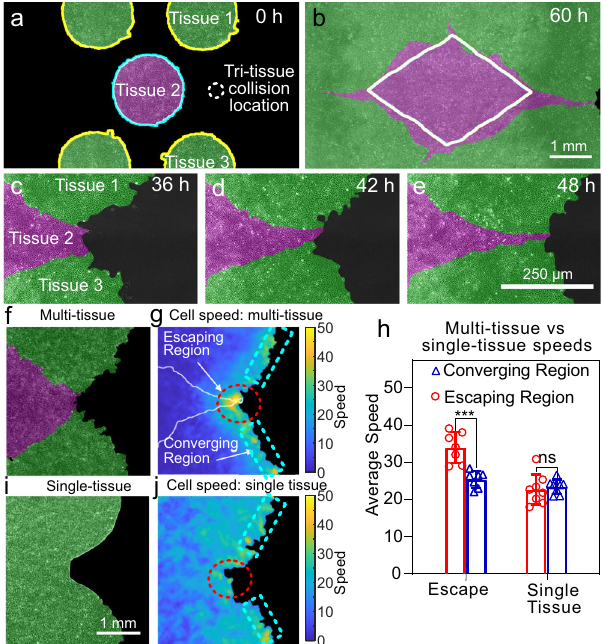
Fig. 5 Tri-tissue collisions produce “ escape ” events. a , b Example con fi guration in which the magenta tissue nearly escapes in between the green tissues during expansion. Labels denote three tissues that participate in a tri-tissue collision leading to an escape event. The white line in b indicates the tissue boundary predicted by our simulation tool TissEllate based on binary collisions. Escapes occur in 50% of cases, n = 14 (Supplementary Fig. 7). c – e Close-up view of the escape process, from a different experiment with higher magni fi cation. The same labeling scheme used as in panel a . Micrographs show one experiment, as representative example of the 7 of 14 independent experiments that resulted in